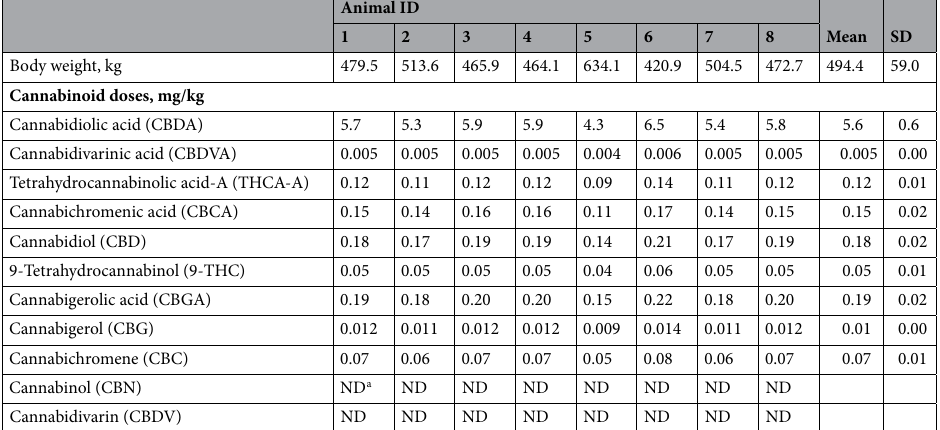
Table 1. Individual animal weights (kg) and doses (mg) of individual cannabinoids administered to each animal in the HEMP group. a ND Cannabinoids not detected in